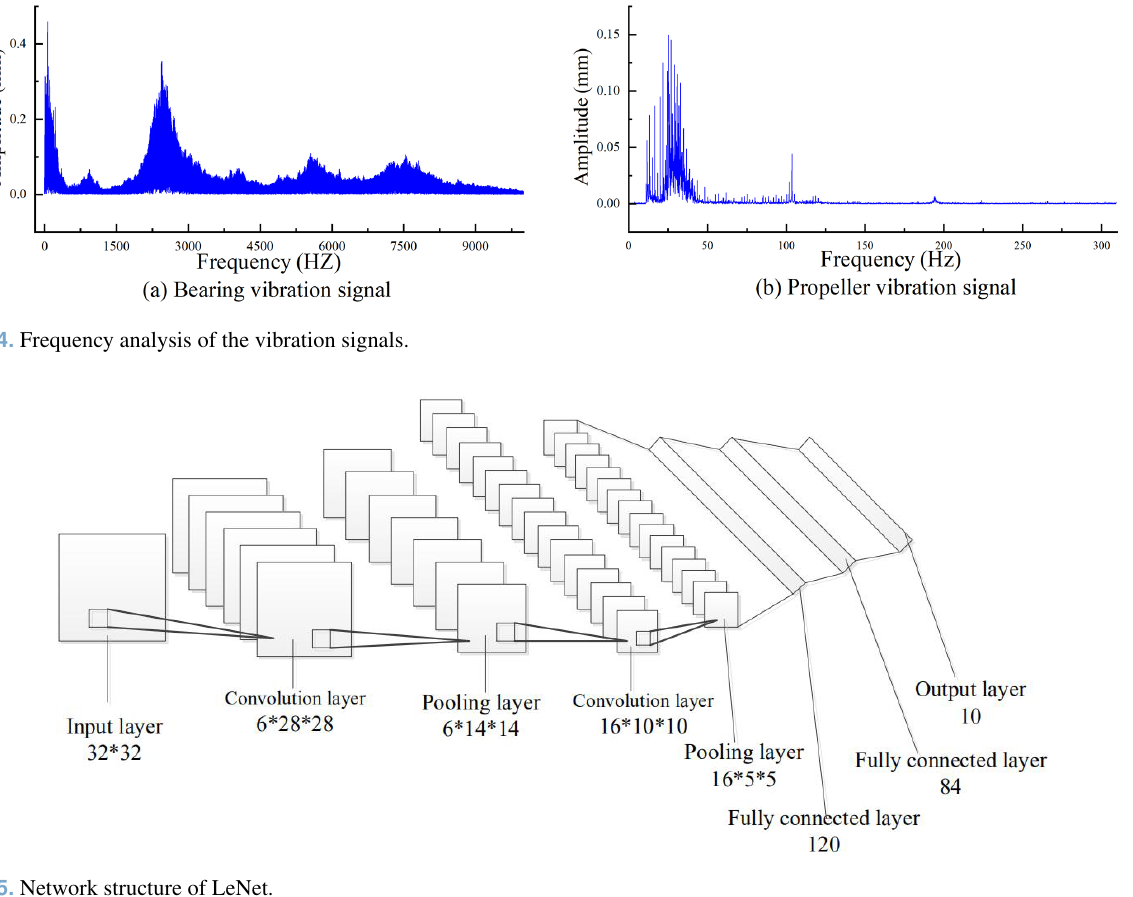
Figure 5. Network structure of